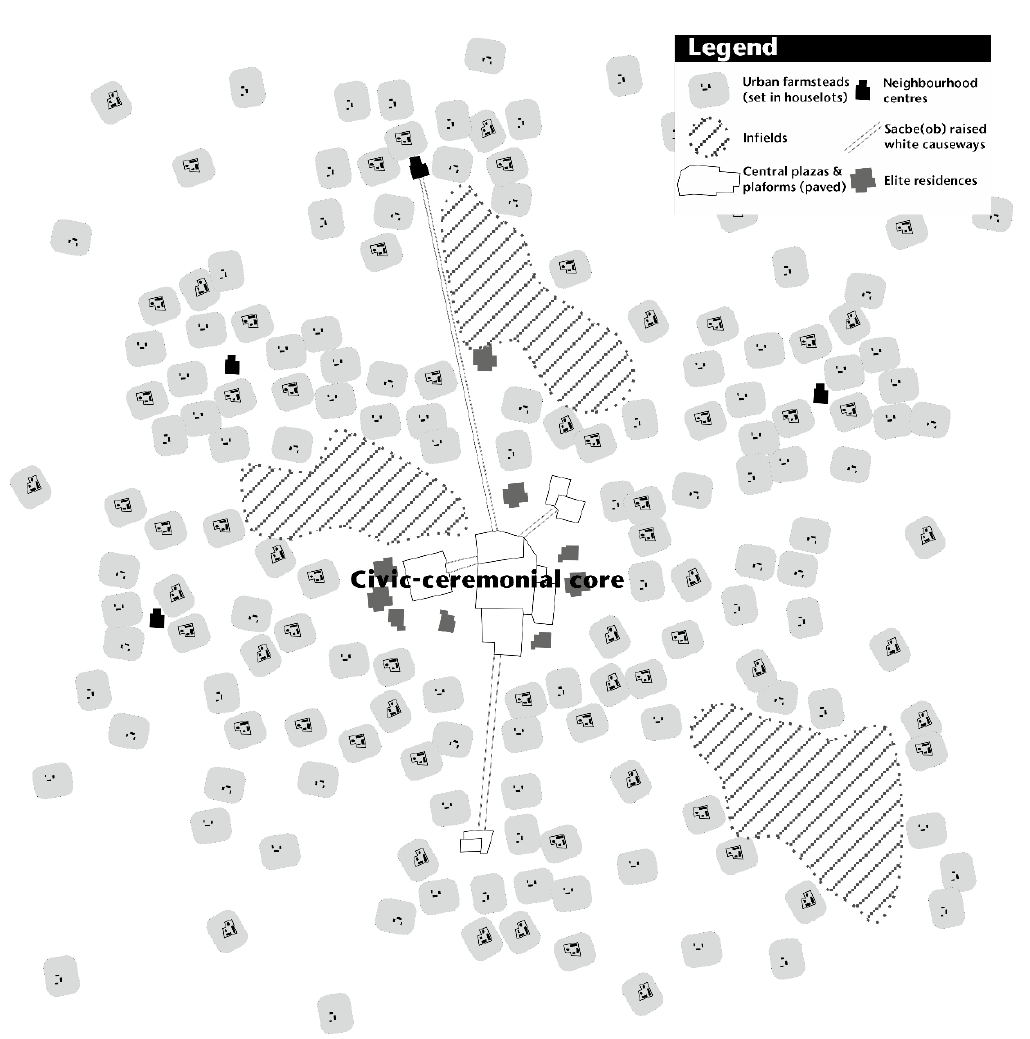
Figure 1. Idealised abstracted map of the general spatial plan of principal elements making up lowland Maya urban settlements (from [5] (p: 5)).